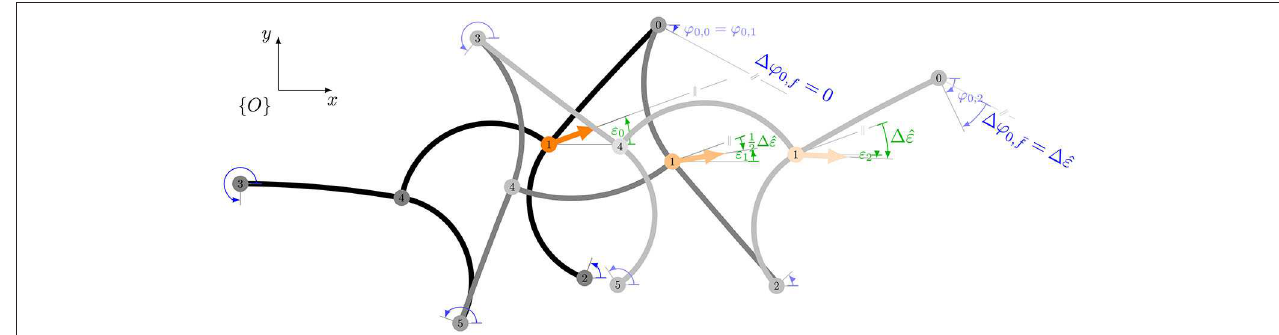
FIGURE 4 | Problem statement: which bending angles must be applied in order to turn the robot while keeping the orientation of its fixed feet? During the first change of pose, the orientation of the front left foot ( ϕ 0 ) and the rear right foot ( ϕ 5 ) should be kept constant. During the second change of pose, the front right foot ( ϕ 2 ) and the rear left foot ( ϕ 3 ) should not